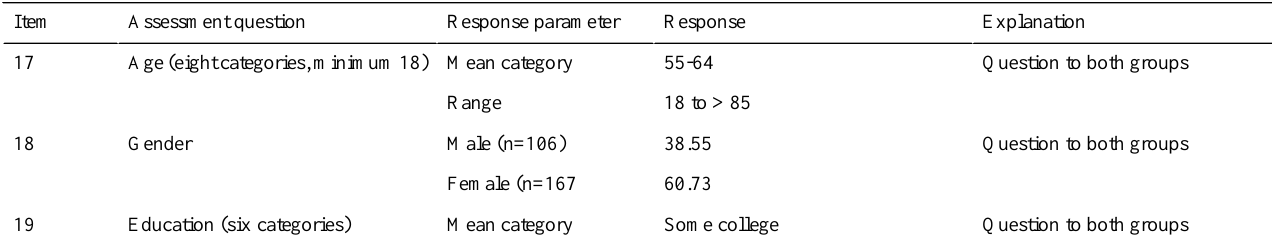
Table 3. Survey results, patient demographic data.